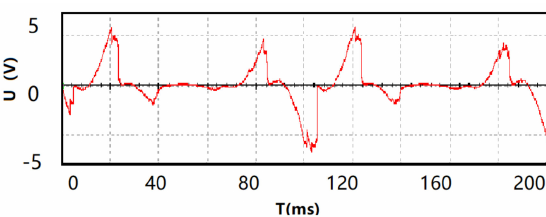
Figure 6. Input signal of mixed